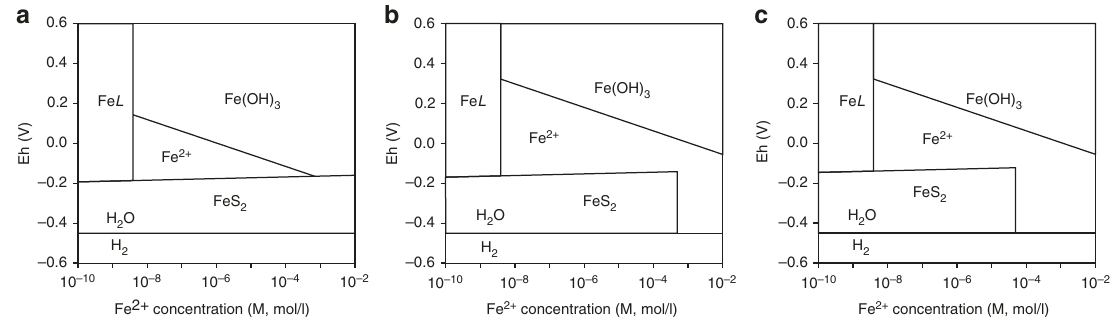
Fig. 4 Thermodynamic models interpreting required ferrous ion concentrations for the formation of BIF and MRB. a Graph of Eh vs. Fe 2+ concentration for Phanerozoic oceans at T = 25 °C and P = 1 bar. The calculations are based on m SO 4 2 − = 15 mM, and pH = 7.5. b Graph of Eh vs. Fe 2+ concentration for Proterozoic oceans at T = 25 °C and P = 1 bar. The calculations are based on m SO 4 2 − = ~1 mM, and pH = 7.0. c Graph of Eh vs. Fe 2+ concentration for Archean oceans at T = 25 °C and P = 1 bar. The calculations are based on m SO 4 2 − = ~100 μ M, and pH = 6.5. The sulfate and pH data used here are from refs 45, 46, 58, 59 . Fe L : iron-binding ligands. The pH values of ancient seawater are consistent with the recent estimates of ~7.5 – 9 for Phanerozoic